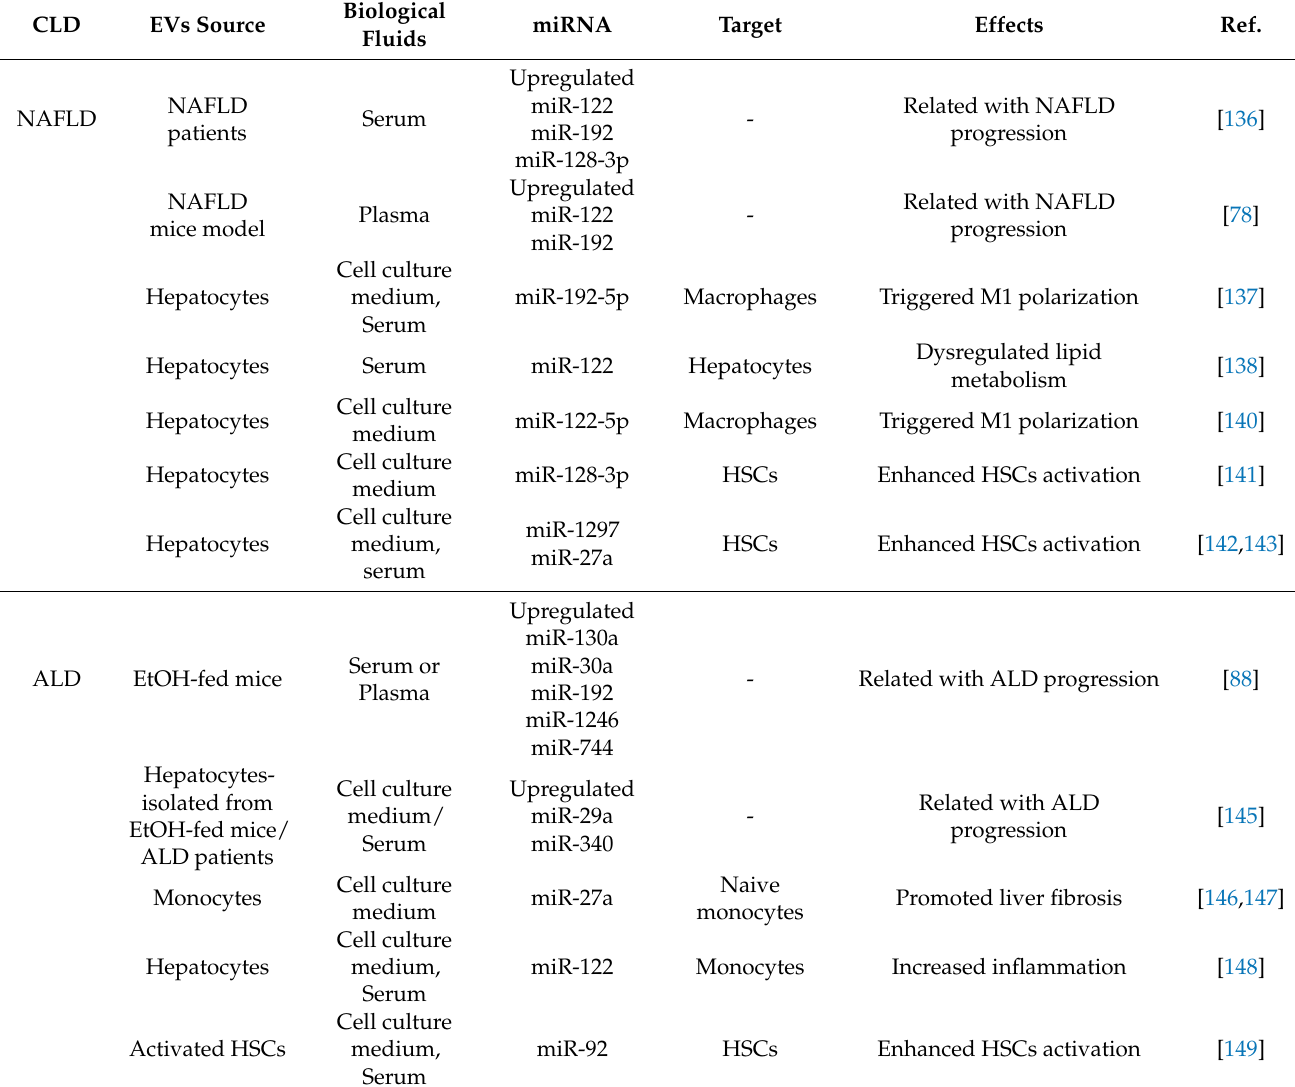
Table 3. Summary of EV-associated miRNAs in progression of CLD.